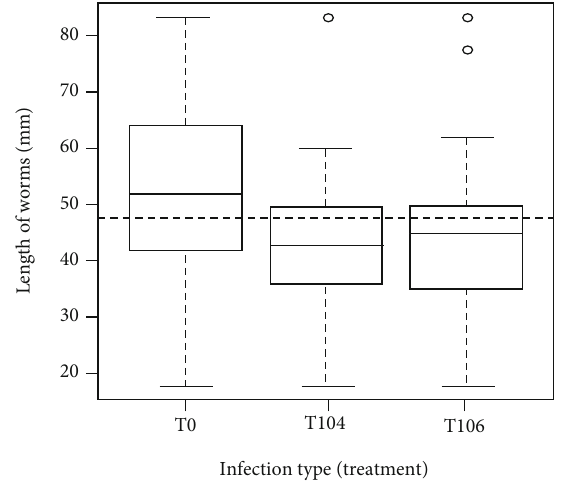
Figure 3: E ff ect of Salmonella typhimurium on Ascaridia galli worm ’ s length. T : concentration 500 worm ova A. galli +0CFUs 0 : concentration 500 A. galli +104 Salmonella typhimurium ; T 104 CFUs Salmonella typhimurium ; T : concentration 500 A. galli 106 +106 CFUs Salmonella typhimurium